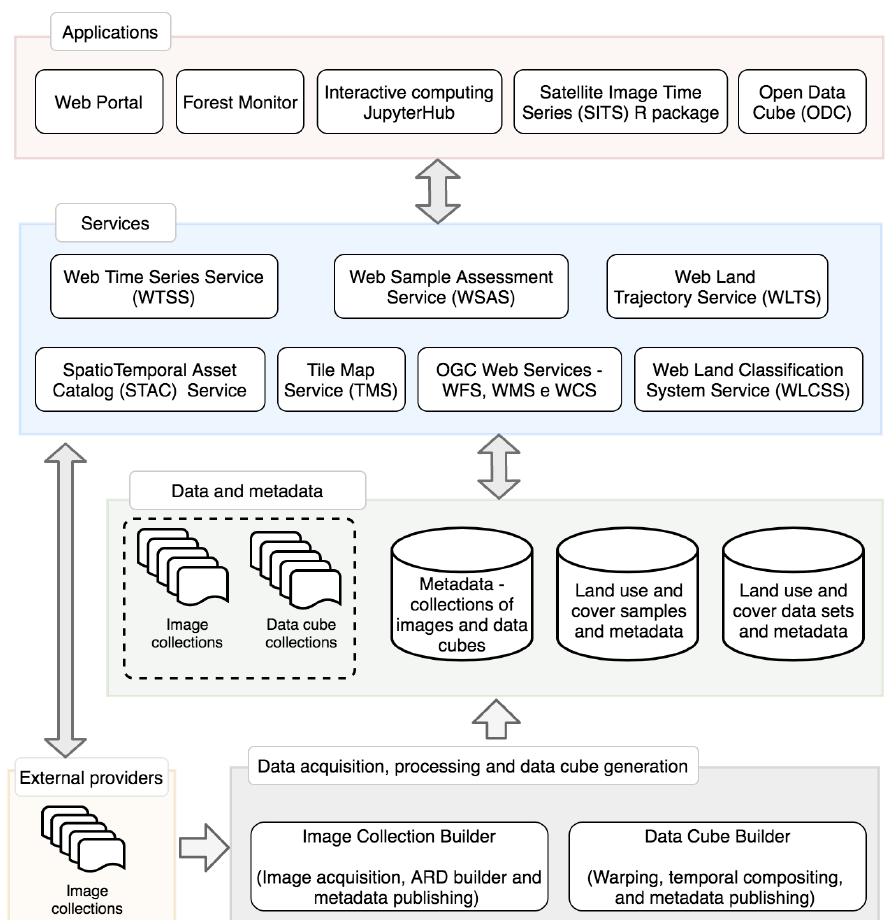
Figure 1. Brazil Data Cube Project: data and software